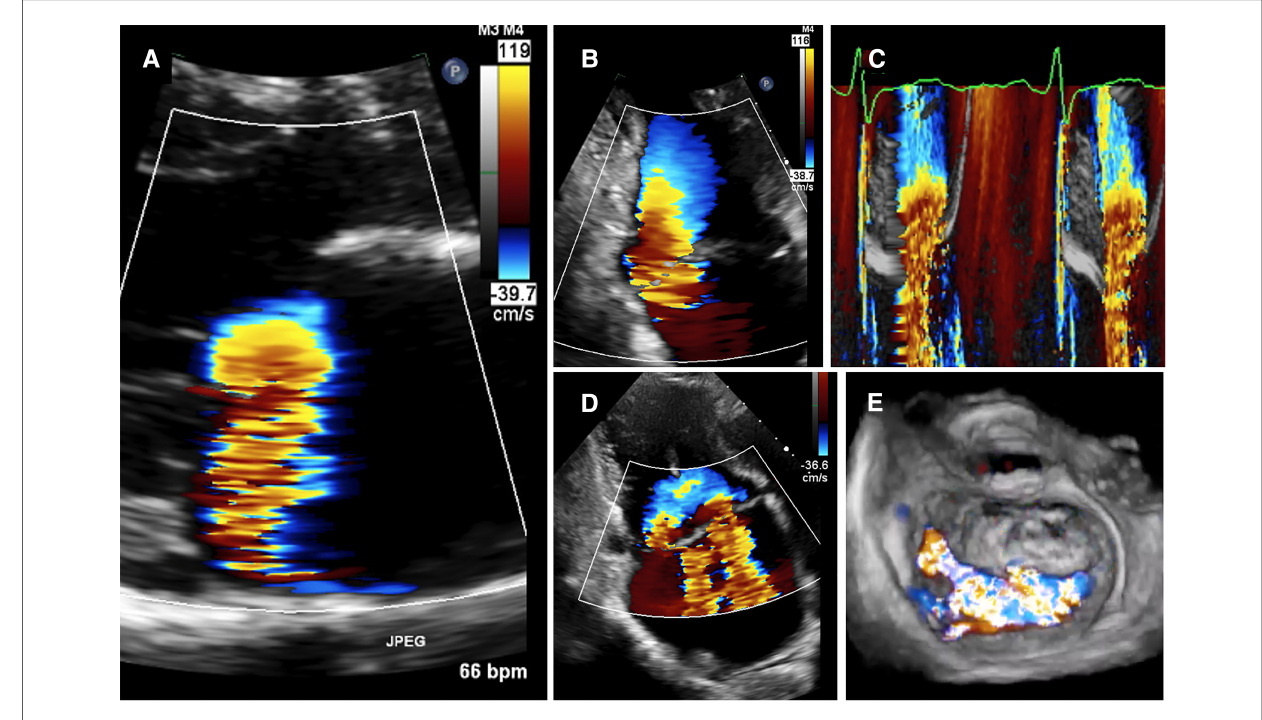
FIGURE 6 Examples of pitfalls of the PISA method. ( A ) Patient with anterior MV prolapse. A clear hemispheric-shaped proximal fl ow convergence is seen on parasternal long-axis view ( A ). However, this is not the most common situation encountered in clinical practice. ( B ) Wall-constrained proximal fl ow convergence with a oblong shape. This is frequently observed in case of posterior MV prolapse or commissural MR. There is a risk of over-estimation of MR EROA and RegVol by the PISA method. ( C ) Late-systolic MR. As shown in Doppler color coupled to M-mode, the MR is only present in the latter part of systole. Therefore the MR EROA which depends on a single time point measurement (the PISA radius) is not reliable to grade MR. ( D ) Multiple MR jets. The PISA method is not reliable to grade MR. Indirect quantitative methods should be considered. ( E ) Bi-lea fl et prolapse with extensive MR from one commissure to another. The PISA method is inapplicable. Indirect quantitative methods should be considered. EROA, effective regurgitant ori fi ce area; LV, left ventricular; MR, mitral regurgitation; MV, mitral valve; PISA, proximal isovelocity surface